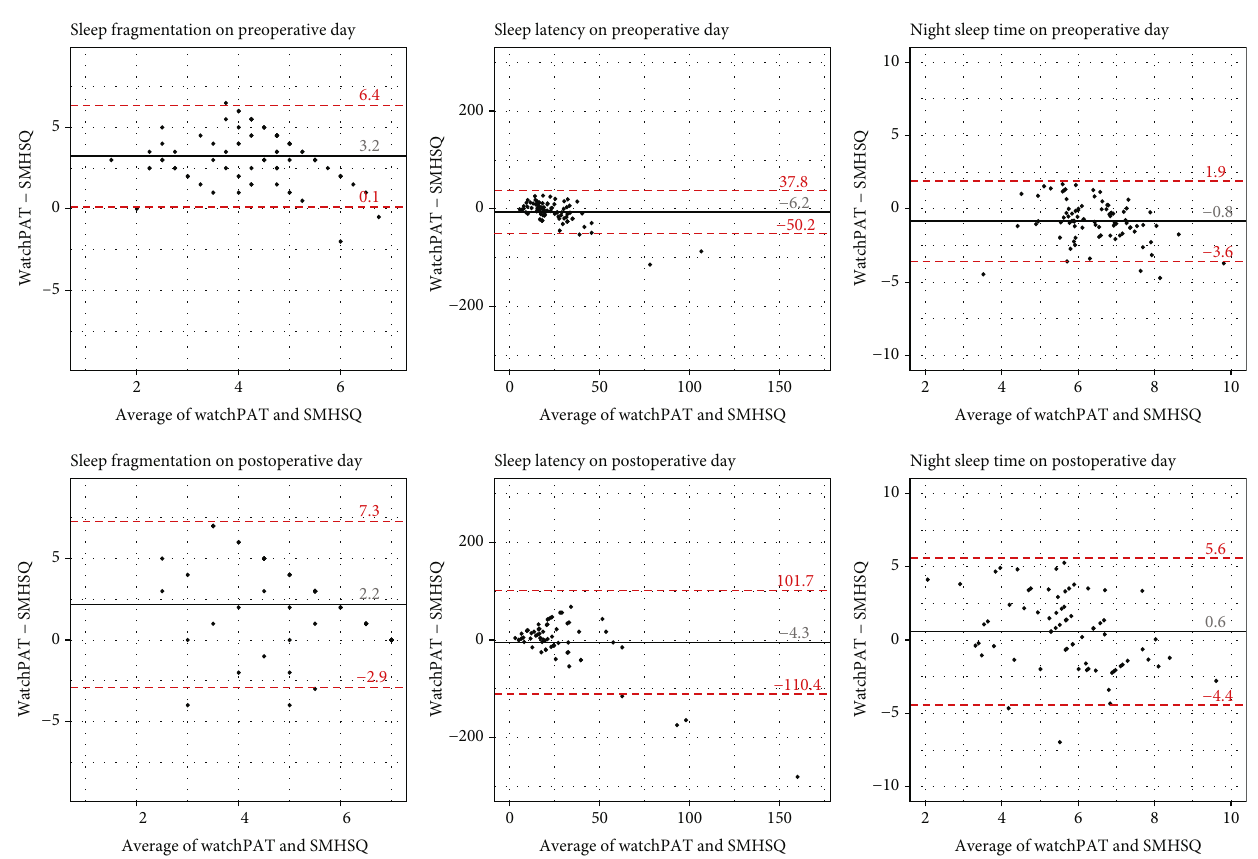
Figure 3: Bland-Altman plots of sleep fragmentation, sleep latency, and total night sleep before and after surgery. SMHSQ: St. Mary ’ s Hospital Sleep Questionnaire. In each plot, the solid black line represents the mean di ff erence (bias), and the red dashed lines represent the 95% limits of agreement of the mean di ff